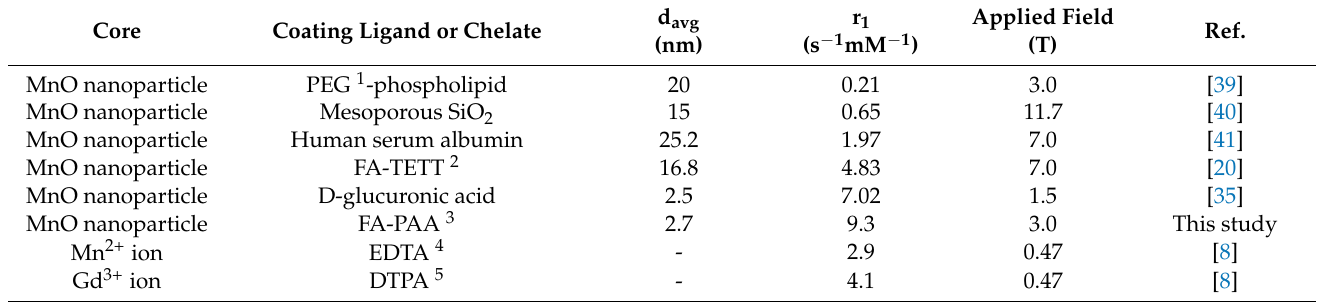
Table 2. Comparison of the r 1 values of various MnO nanoparticles and metal-ion chelates. Core Coating Ligand or Chelate MnO nanoparticle PEG 1 -phospholipid MnO nanoparticle Mesoporous SiO 2 MnO nanoparticle MnO